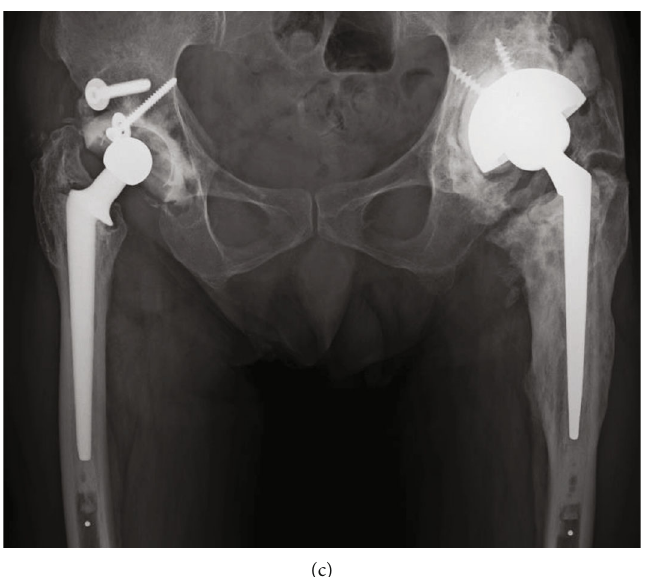
Figure 4: (a) Plain radiograph of a 78-year-old man obtained prior to the third THA, showing a clear zone around the cemented cup. Abbreviations: THA: total hip arthroplasty. (b) Plain radiograph of a 78-year-old man obtained immediately after the third THA,